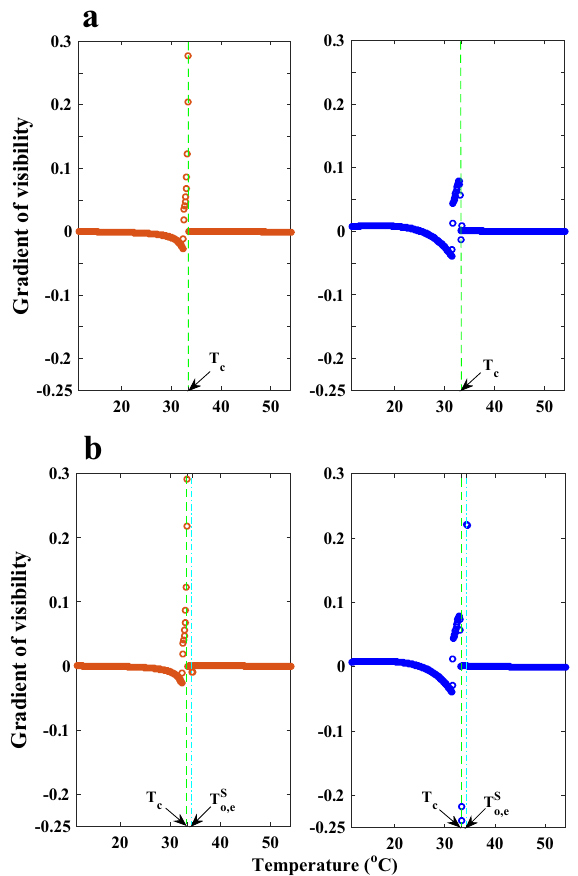
Figure 13. Comparing the gradient visibilities: ( a ) without taking into account the ordered surface film effect. ( b ) By taking into account the ordered surface film effect. It is evident that whereas the ordinary visibility gradient has barely changed, the extraordinary visibility gradient has seen major